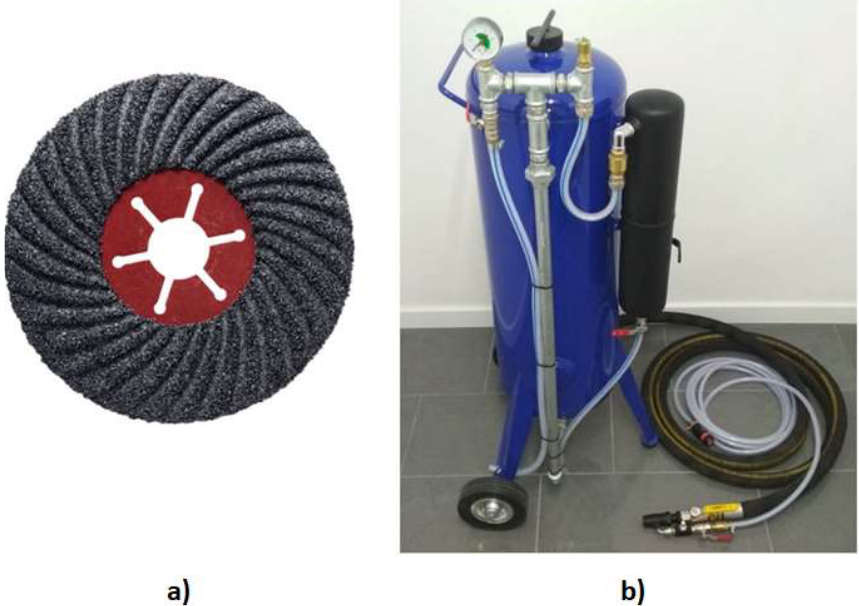
Figure 5. Ceramic grinding disc ( a ) and siphon blasting machine with a water nozzle ( b ).